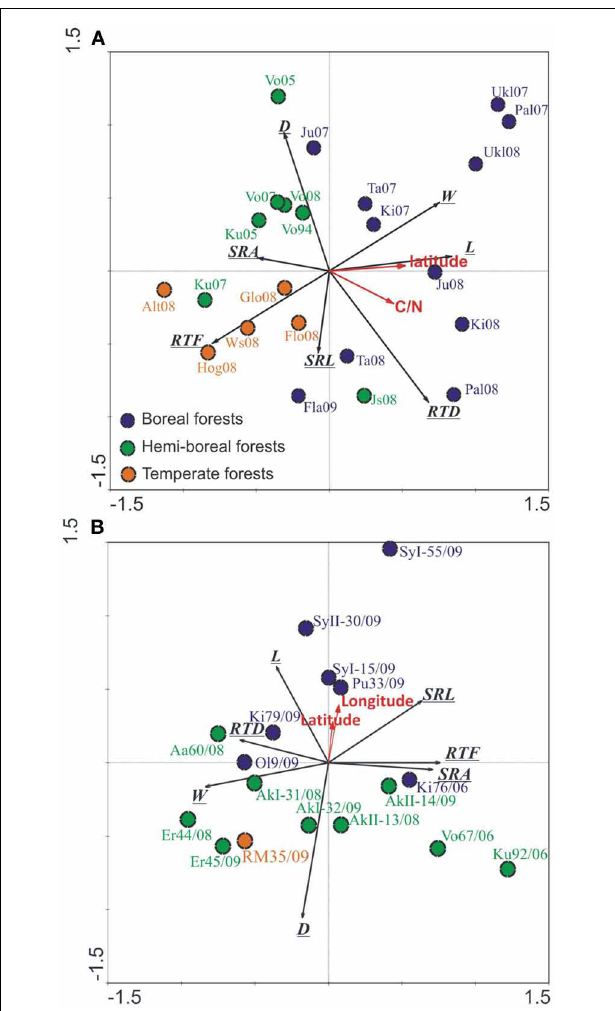
FIGURE 4 | Ordination of the spruce (A) and birch (B) forests (older than 10 years) on native forest land based on EcM morfological parameters [SRL, SRA, tissue density (RTD), diameter (D), length (L), mass (M), and tip frequency (RTF)]. Norway spruce forests were separated to boreal (blue, > 60 ◦ N), hemi-boreal (green) and temperate (red) forests. Silver birch stands were separated to boreal (blue, > 60 ◦ N) and hemiboreal as well as temperate forests (red, < 60 ◦ N). Latitude, soil C/N ratio and sites accounted for 32.9% of total variability of EcM morphological traits in spruce forests, Axis1 described 18% and Axis2 9.9%, respectively, p = 0 . 001. In birch forests, the latitude, longitude and sites accounted for 23.9% of total variability of EcM morphological traits, axis 1 described 12.4% and axis 2 7.3%, respectively, p = 0 . 001.